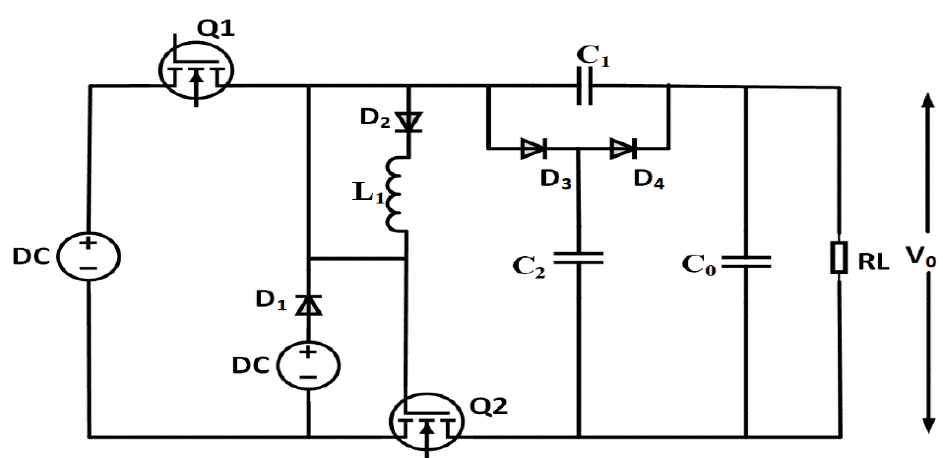
Figure 18. Buck-based dual input–single output converter.